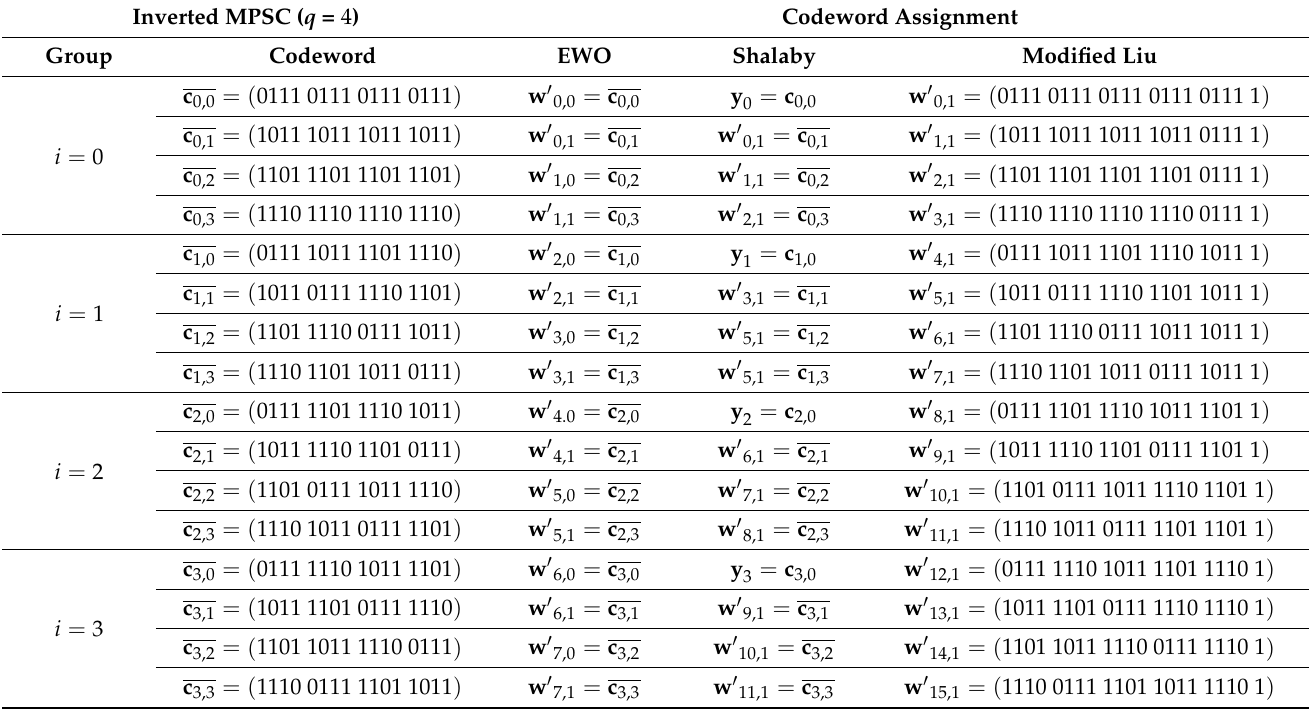
Table 4. Codeword assignment for inverted MPSC ( q =